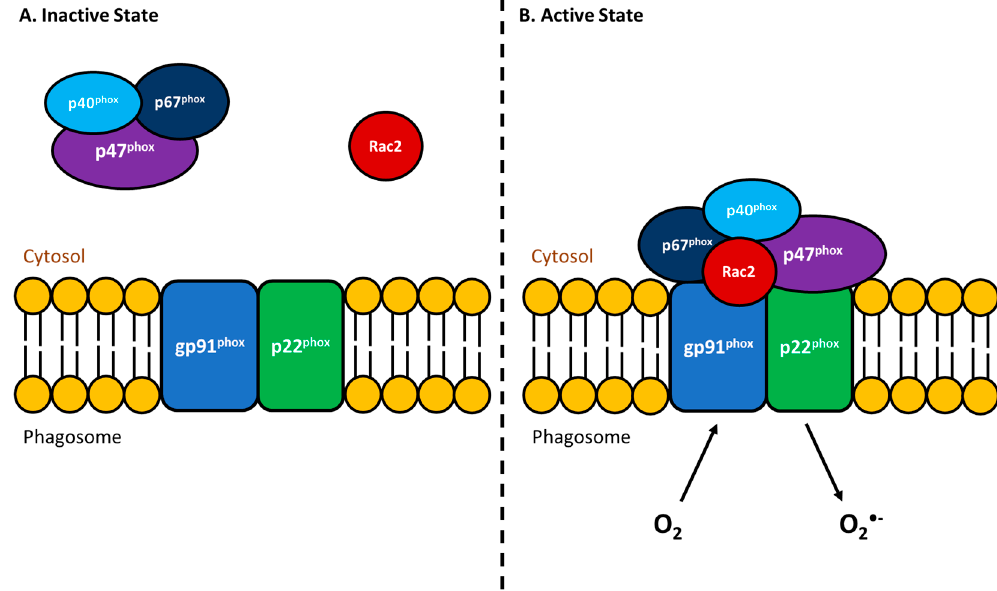
Figure 1. Schematic depiction of NADPH oxidase activation to enable the respiratory burst activity of phagocytes. The NADPH oxidase enzyme consists of six subunits. ( A ) When the phagocyte is in an inactive state, two of the subunits (gp91 phox and p22 phox ) are transmembrane components, while the remaining four components are cytosolic (p40 phox , p47 phox , p67 phox and Rac2). ( B ) Upon the phagocyte being activated by external stimuli, the four cytosolic components complex with gp91 phox and p22 phox to form the active NADPH oxidase. When in the active form, the now functional enzyme can convert molecular oxygen into superoxide anions to aid in the degradation or killing of that which was phagocytosed.